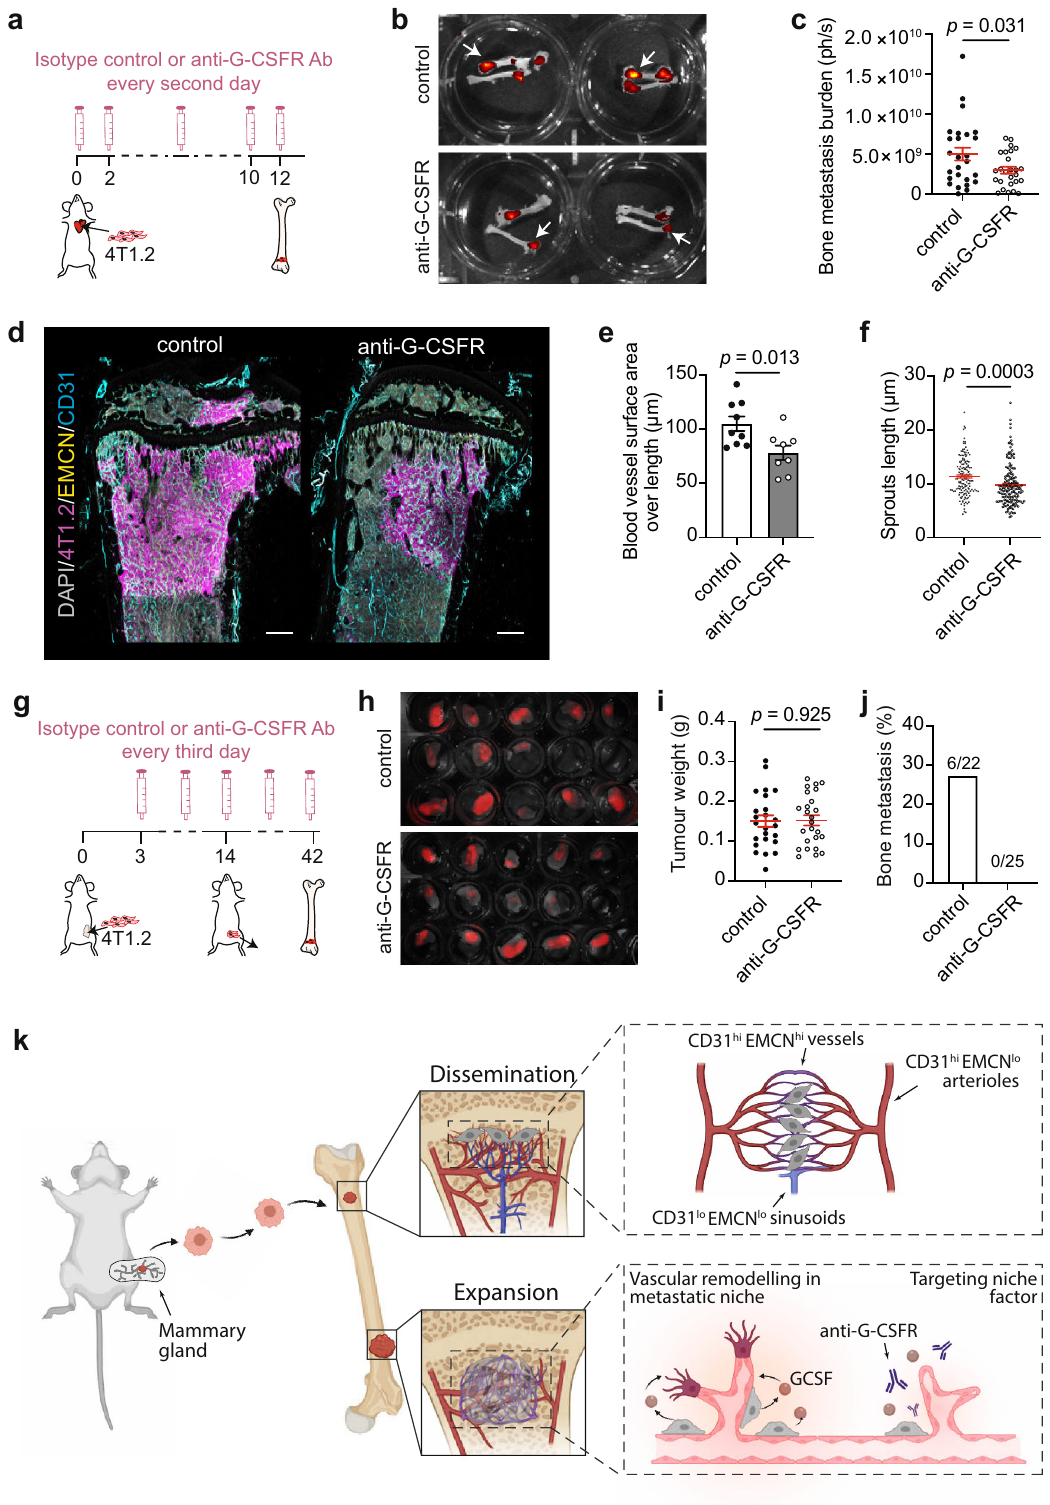
because chemotherapy treatment has been shown to damage the bone vascular network 41 and in turn potentially compromised the anti-vascular remodelling effect of blocking Ab treatment (Supplementary Fig. 6k – m). Overall, the therapeutic inhibition of G-CSF-dependent vessel remodelling may represent a potential strategy to impede bone